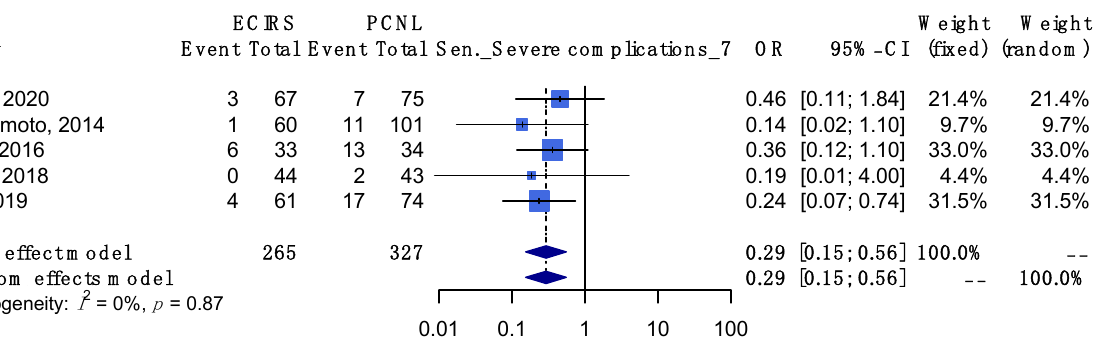
Figure A21. Sensitivity analysis of outcome regarding overall complications. ([17–20,22,23]).